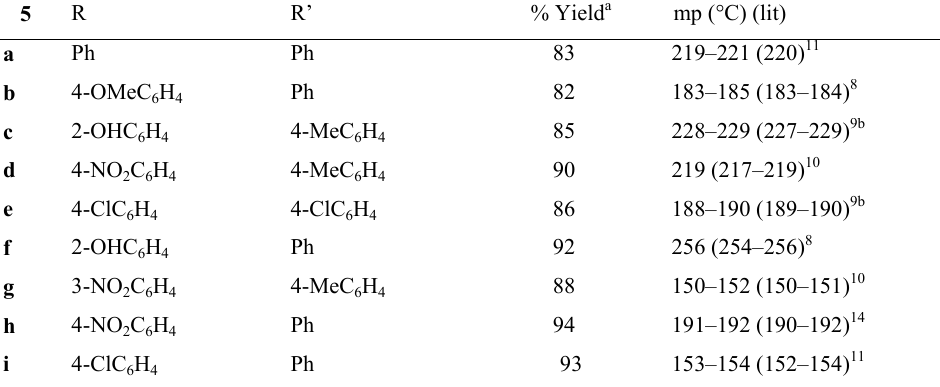
Table 2. Synthesis of 1,2,4,5-tetrasubstituted imidazole